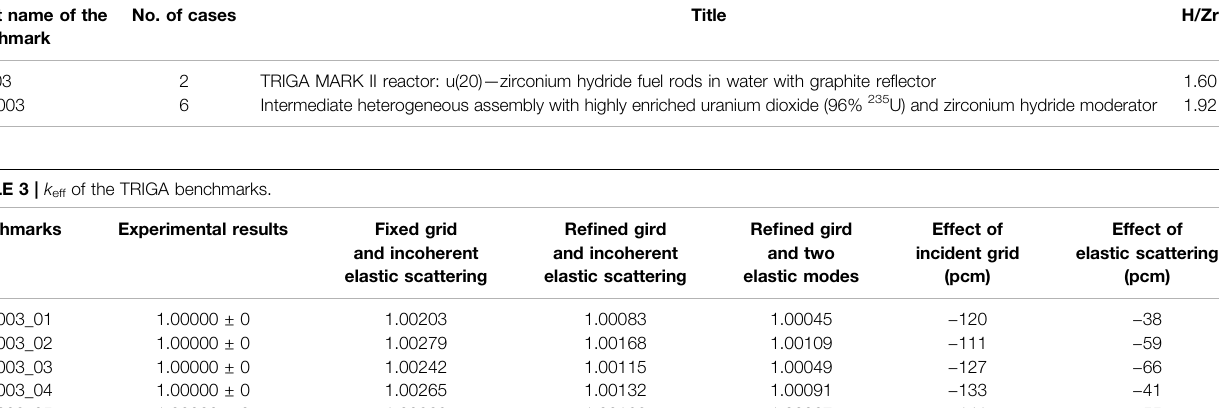
TABLE 2 | ICSBEP criticality benchmarks used in the comparison. Short name of the No. of cases benchmark